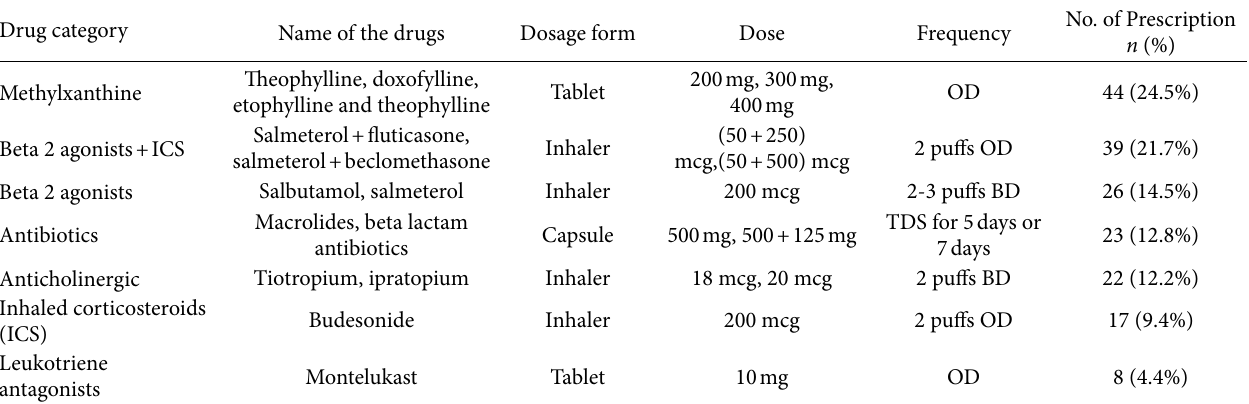
Abbreviations: ICS, Inhaled corticosteroids; OD, Once daily; BD, twice daily; mg, milligrams; mcg,